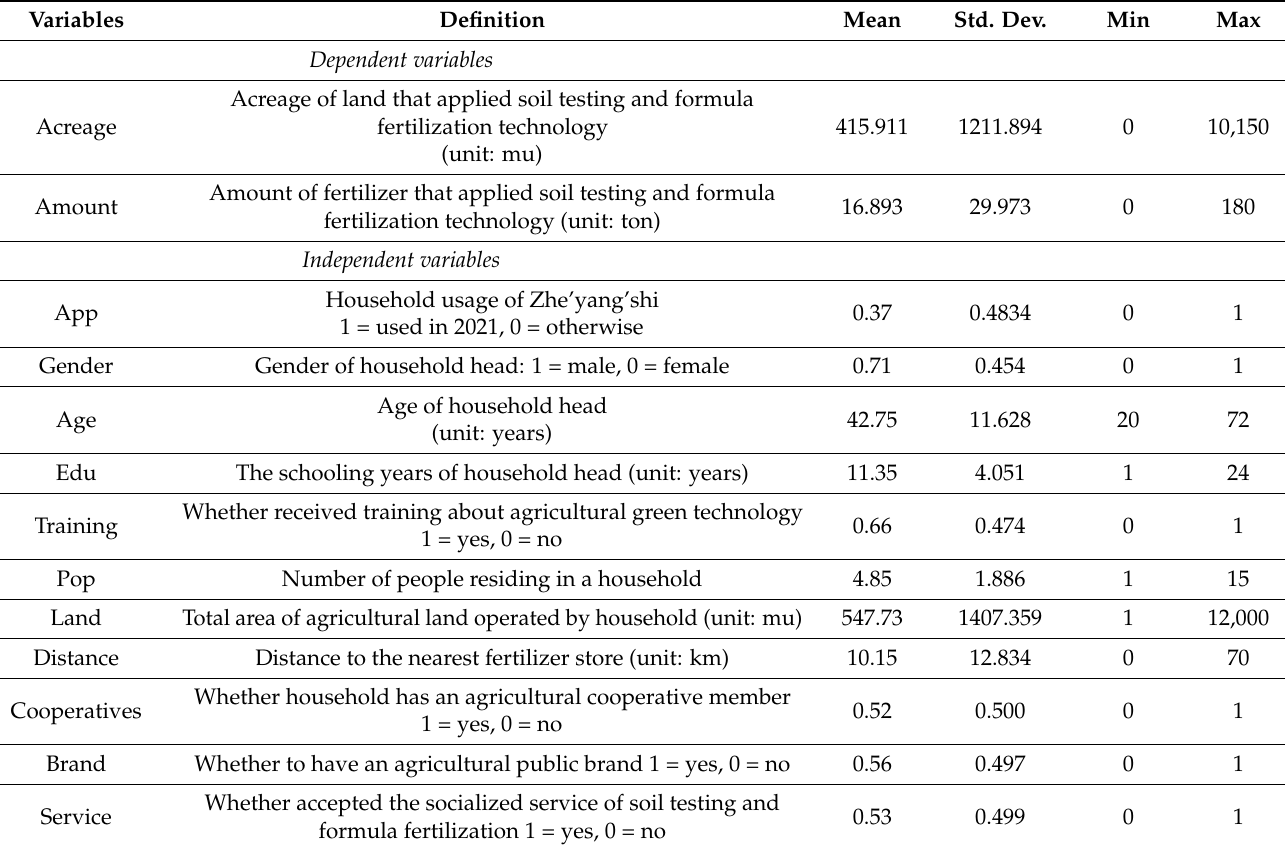
Table 1. Definition of the variables and descriptive